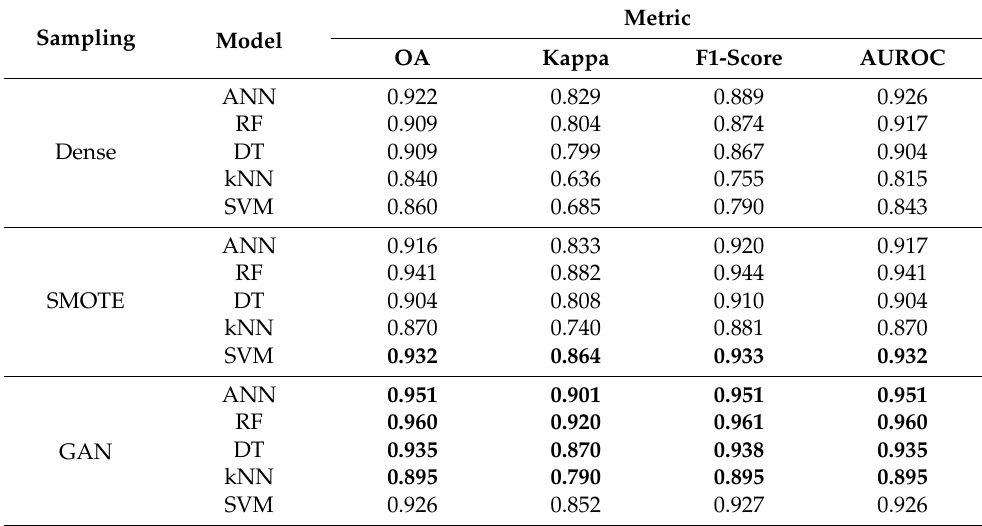
Table 5. Assessment of models with datasets created based on a ratio of 1:2. Sampling